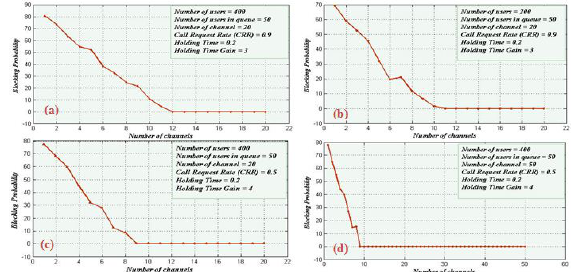
Fig. 9. Time blocking probability versus no. of channels